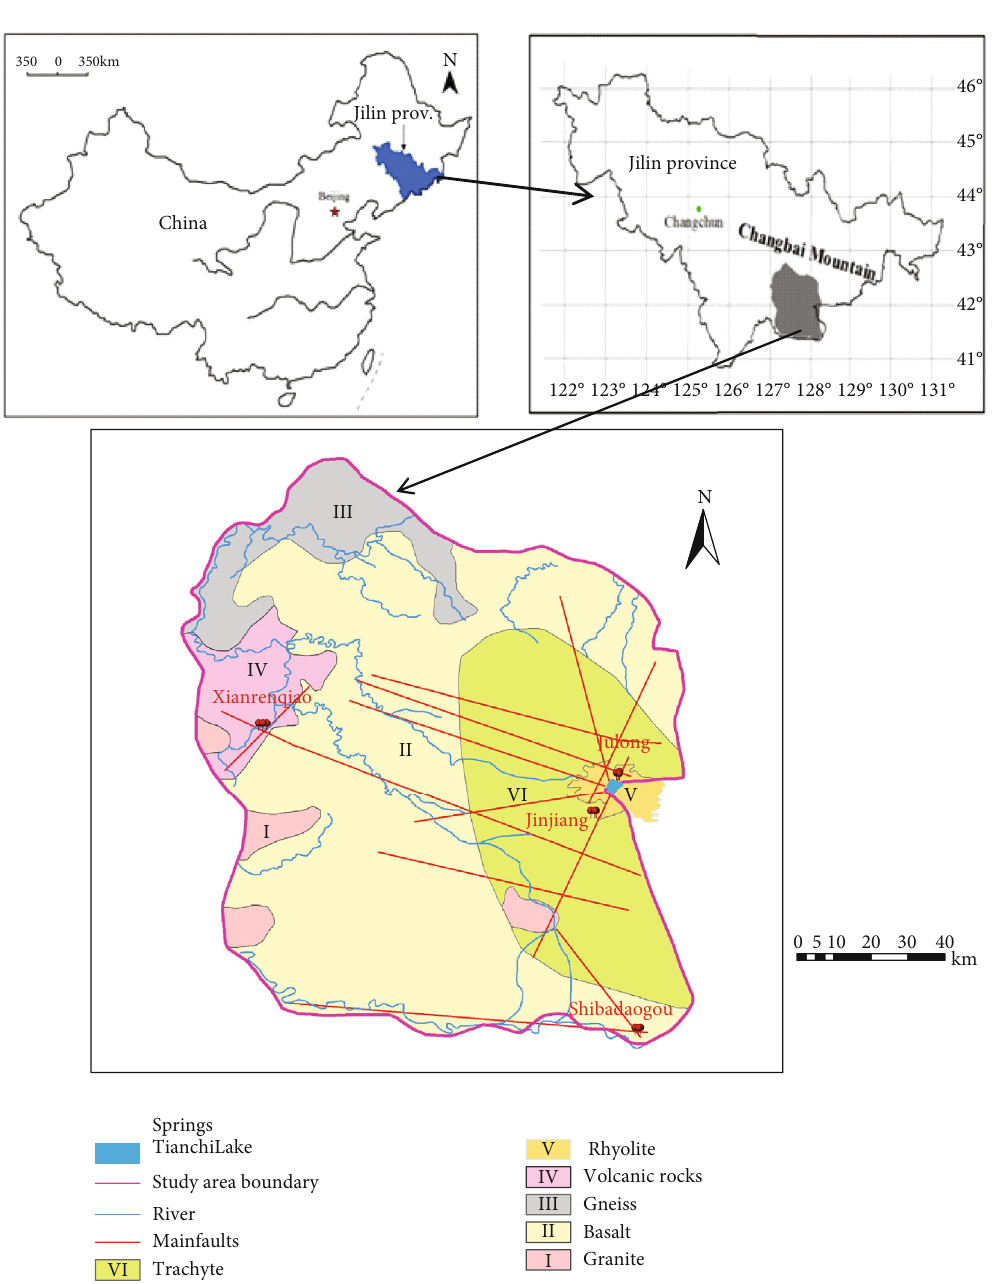
Figure 1: Geology and hydrogeology in the Changbai Mountain region [5,